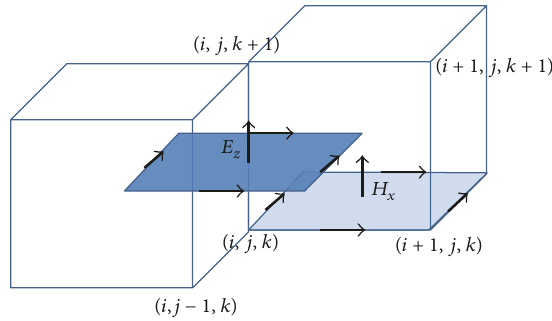
󳨀⇀ 𝐻 in two adjacent unitary